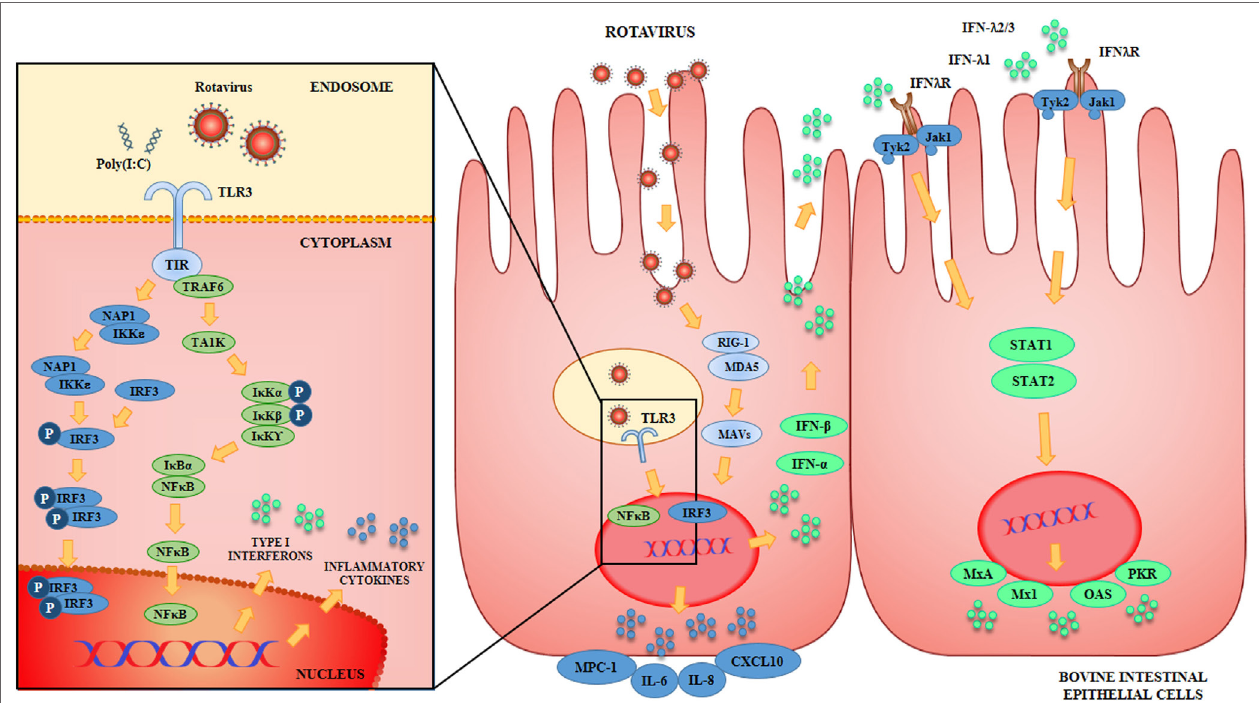
FiGURe 1 | Antiviral Innate immune response against rotavirus in bovine intestinal epithelial (BIE) cells. Rotavirus double-stranded genomic RNA activates toll-like receptor 3 (TLR3), retinoic acid inducible gene-I (RIG-I), and melanoma differentiation-associated gene-5 (MDA-5), which are pattern recognition receptors (PRRs) expressed in BIE cells. Cellular signaling cascades are activated and converge at the level of interferon (IFN) regulatory factor-3 (IRF3) that upregulate the expression of type I (IFN- α , IFN- β ) and type III (IFN λ 1, IFN λ 2/3) IFN, which in turn induces the synthesis of IFN-stimulated genes with antiviral activities including: myxovirus resistance 1 IFN-inducible protein (Mx1), MxA, ribonuclease L (RNaseL), 2 ′ -5 ′ -oligoadenylate synthetase (OAS), and protein kinase R (PKR). Antiviral PRRs also activate nuclear factor κ B (NF- κ B) pathway and induce the secretion of proinflammatory cytokines and chemokines including: interleukin 6 (IL-6), IL-8, monocyte chemotactic protein 1 (MCP-1/CCL2), and IFN gamma-induced protein 10